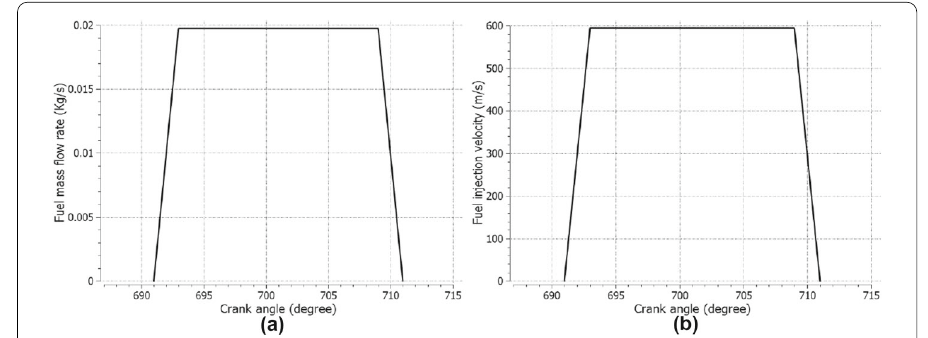
Fig. 4 a Mass flow rate profile of fuel injection vs crank angle, b Velocity profile of fuel injection vs crank angle